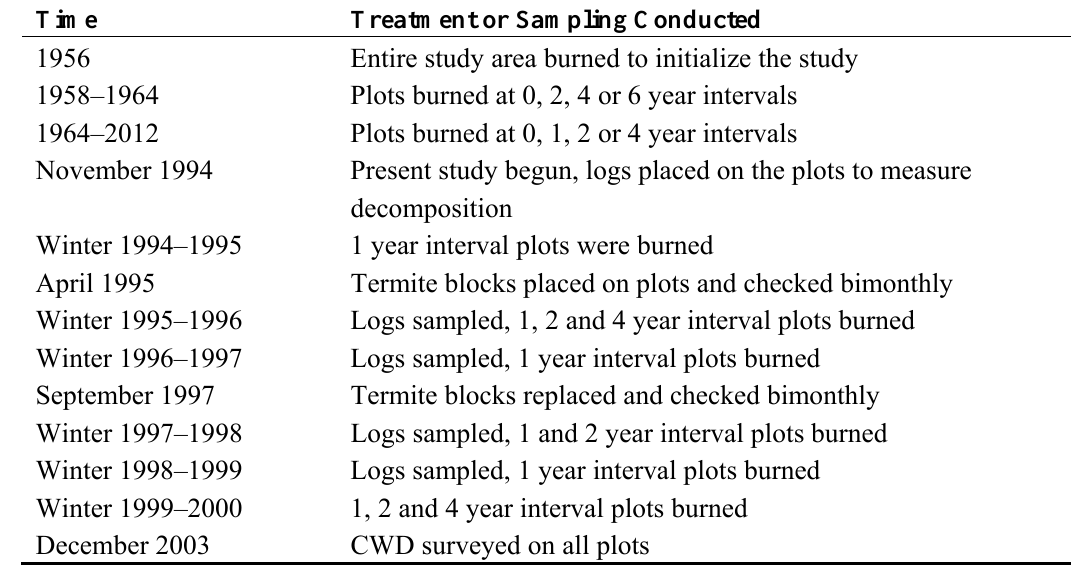
Table 1. Timeline from initial plot establishment through the present study showing when samples were collected and prescribe burning treatments applied for a long-term burn study on the Osceola National Forest in